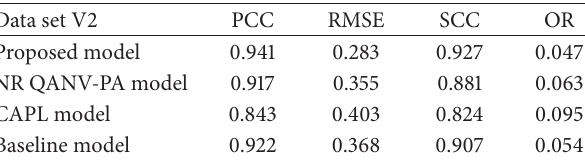
Table 10: Performance comparison between objective data and subjective